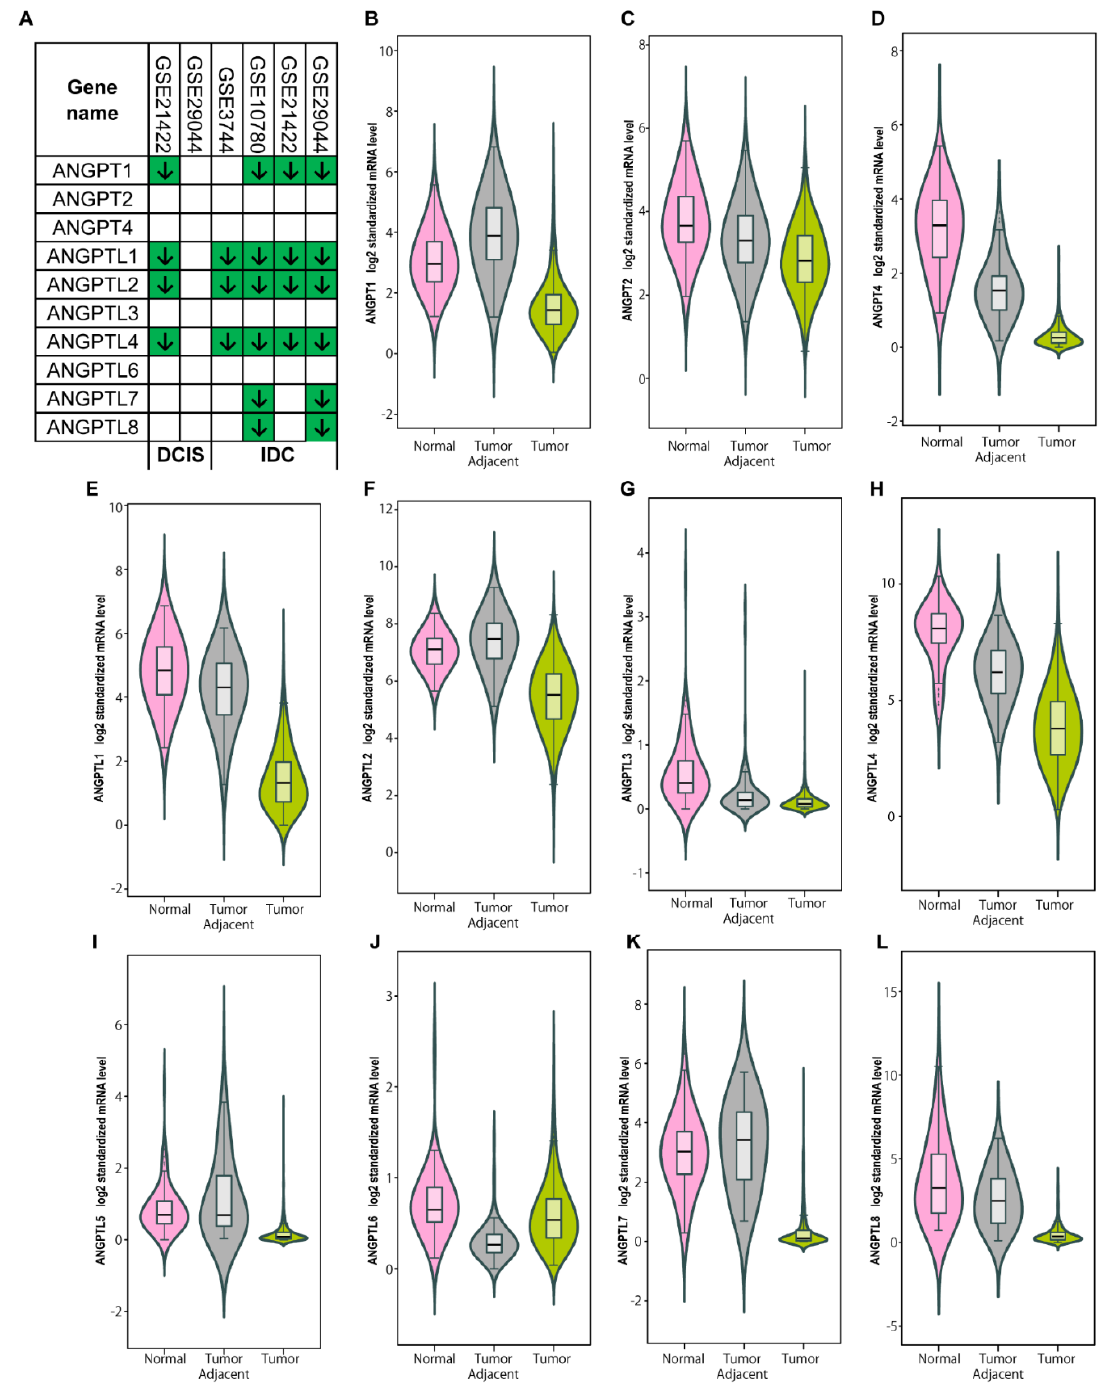
Figure 1. ANGPTL1 , 2 , and 4 are consistently downregulated in breast cancers (BCs). ( A ) Comparison of transcriptional expression of ANGPT / ANGPTL genes between normal breast and BC tissues in multiple microarray datasets. Significantly decreased gene expression (1.5-fold; adjusted p < 0.05) is shown in green with an arrow. ( B – L ) Box plot of transcriptional expression of the ANGPT / ANGPTL genes in normal, tumor-adjacent, and tumor tissues by RNA-seq analysis in TCGA dataset. Boxes represent the median and interquartile ranges between the first and third quartiles. Number of normal breast tissues = 92; number of breast-tumor-adjacent tissues = 104; number of breast tumor tissues =